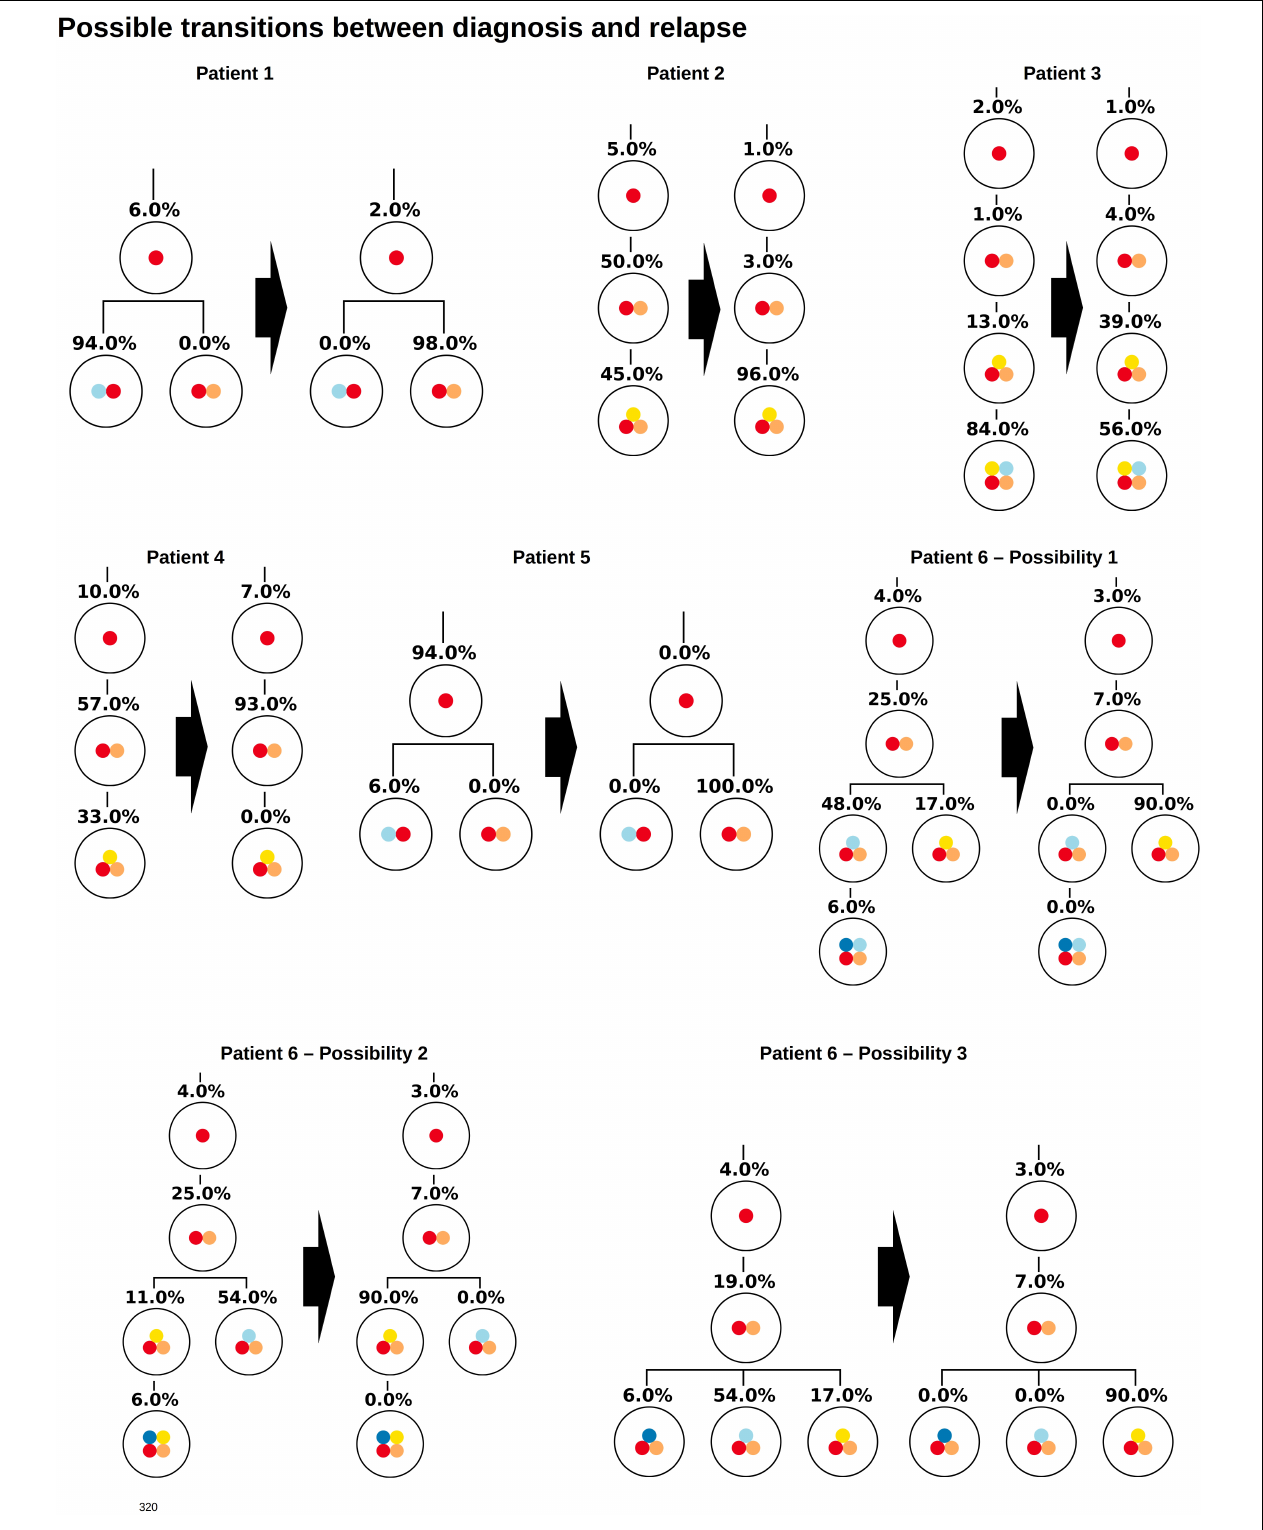
FIGURE 4 | Clonal hierarchies compatible with the bulk allele frequencies measured at diagnosis and relapse. For each patient, the figure shows all clonal hierarchies that are compatible with the bulk VAFs measured at diagnosis and relapse. The root of the tree corresponds to the founder mutation. We observe that in case of patient 6, the number of hierarchies compatible with the data is reduced compared to Figure 2 . For patients 1–5, the reconstructed hierarchies coincide with the result from single cell sequencing. For patient 6, Possibility 3 corresponds to the true configuration.